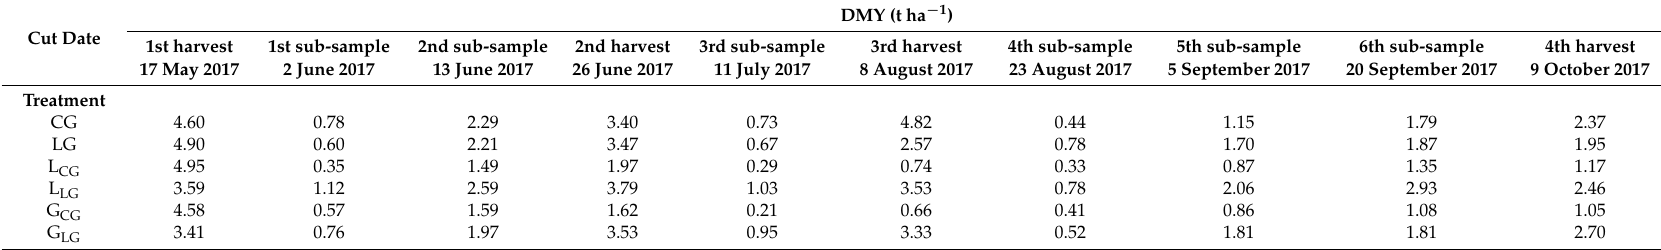
Table A1. Dry matter yield (DMY) of the different treatments: the clover-grass (CG) and lucerne-grass (LG) mixtures and pure stands of legumes (L) and grasses (G) for 10 sampling dates comprising four harvest cuts and six sub-samplings every second week during sward growth between 17 May 2017 and 9 October